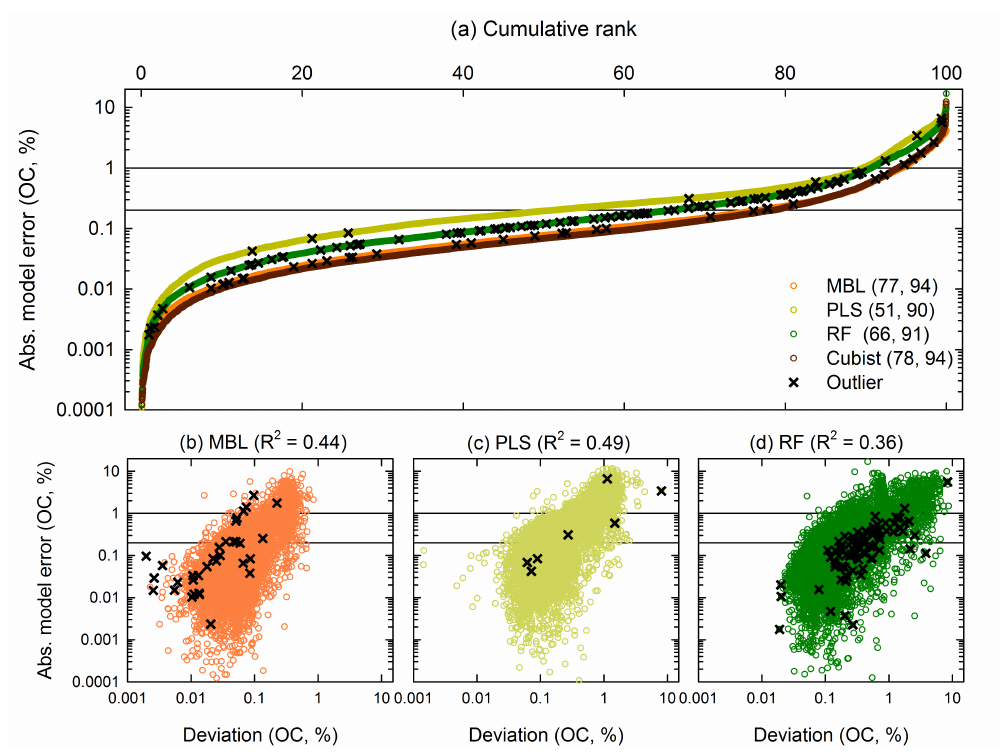
Figure 4. Absolute model error and uncertainty estimates (deviation) of independent validation sets for OC using the MBL, PLSR, RF and Cubist models. The plot in the top panel ( a ) shows the cumulative rank of the absolute difference between the predicted and observed values (N = 8512). The numbers in parentheses are the % of samples above 0.2 and 1.0 wt % of absolute error. Only absolute error is shown for Cubist. The figures in the bottom panel ( b – d ) show the relationship between absolute model error and deviation using the MBL, PLSR and RF models. The black cross symbols are the samples that were flagged as untrustworthy predictions using the MBL, PLSR and RF